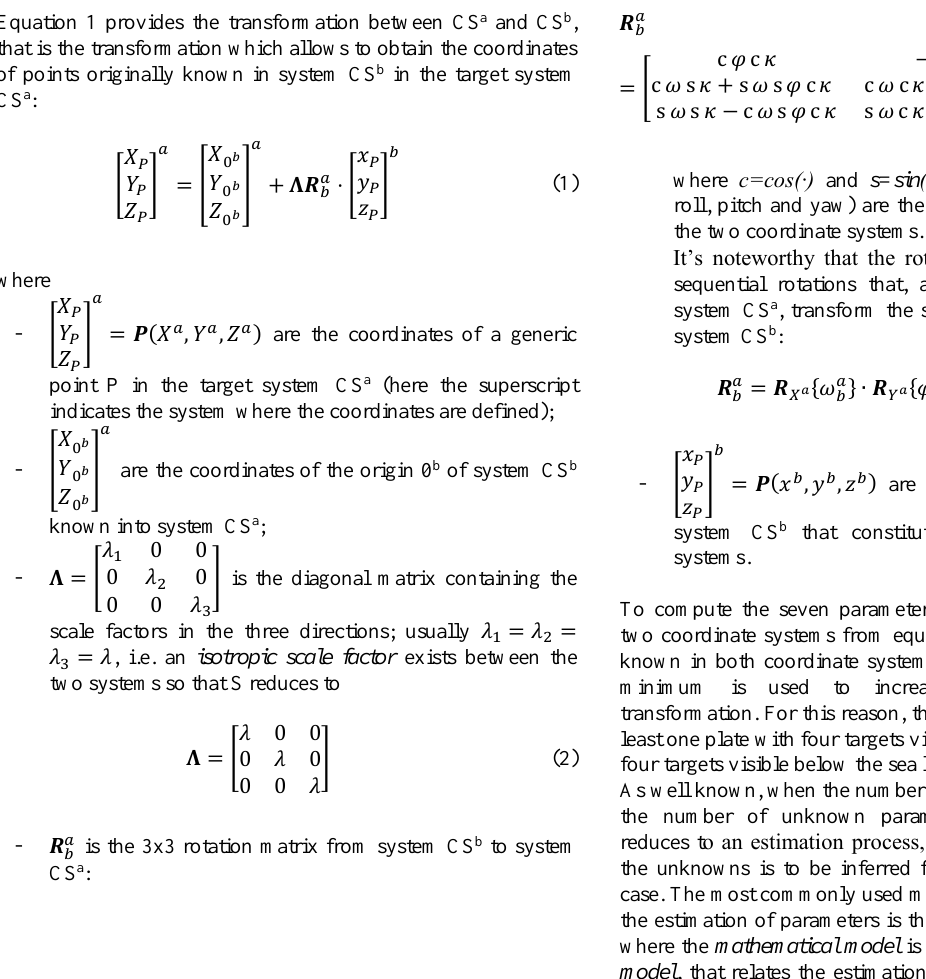
Equation 1 provides the transformation between CS a and CS b